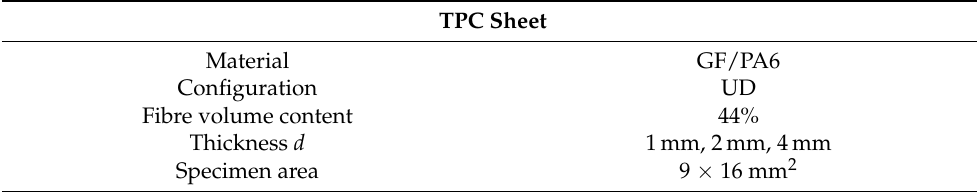
Table 1. Specification of the used material.